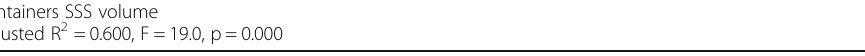
Table 8 Containers SSS model